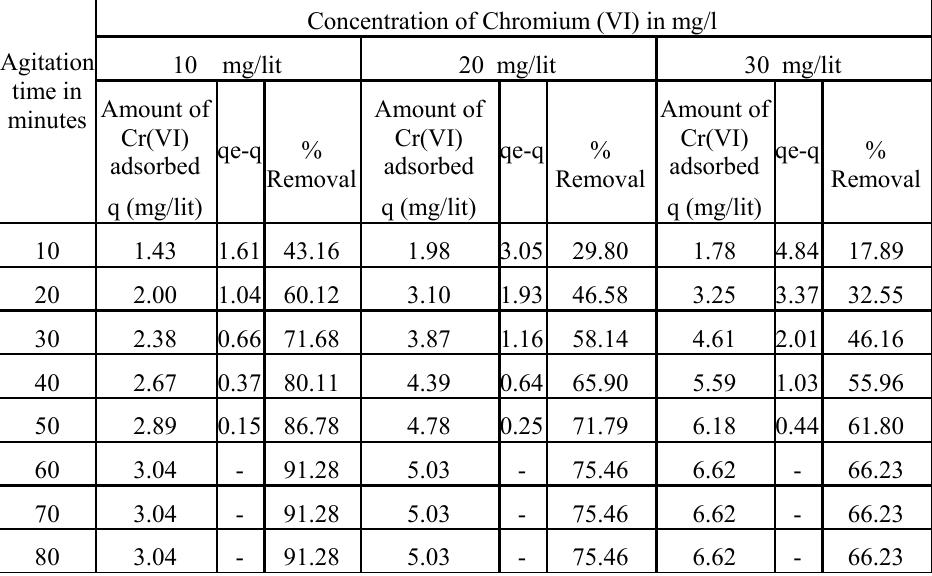
Table 3. Adsorption of Cr (VI) at different agitation times at different concentration.